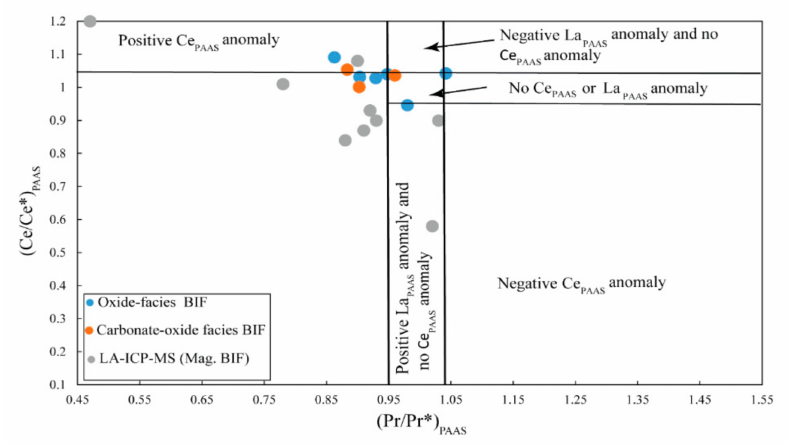
Figure 10. PASS-normalized Ce/Ce* vs. Pr/Pr* diagram, showing La and Ce anomalies (after [3]) for the Nabeba